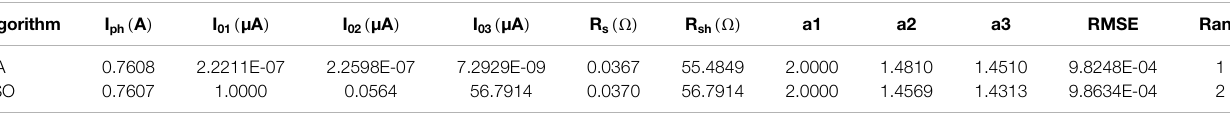
TABLE 7 | Model parameters identi fi ed by various algorithms for the